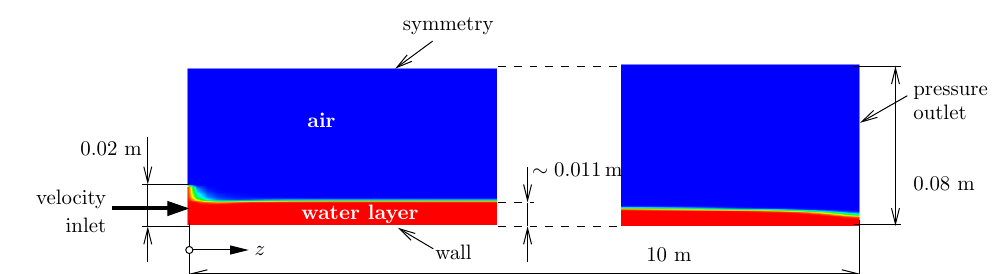
Figure 1. Basic geometry 2-D showing volume fraction of water (red color—volume fraction of liquid is 1, blue color—volume fraction is 0) in the given system. Boundary conditions used in our simulations are depicted in the figure.